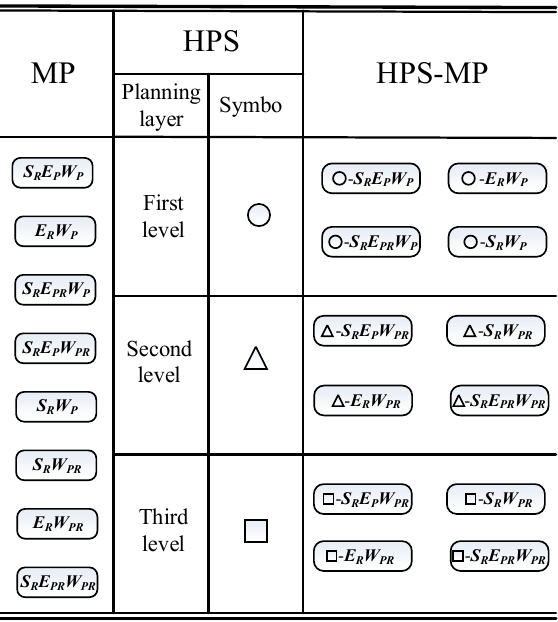
Figure 4. The diversified arm motion